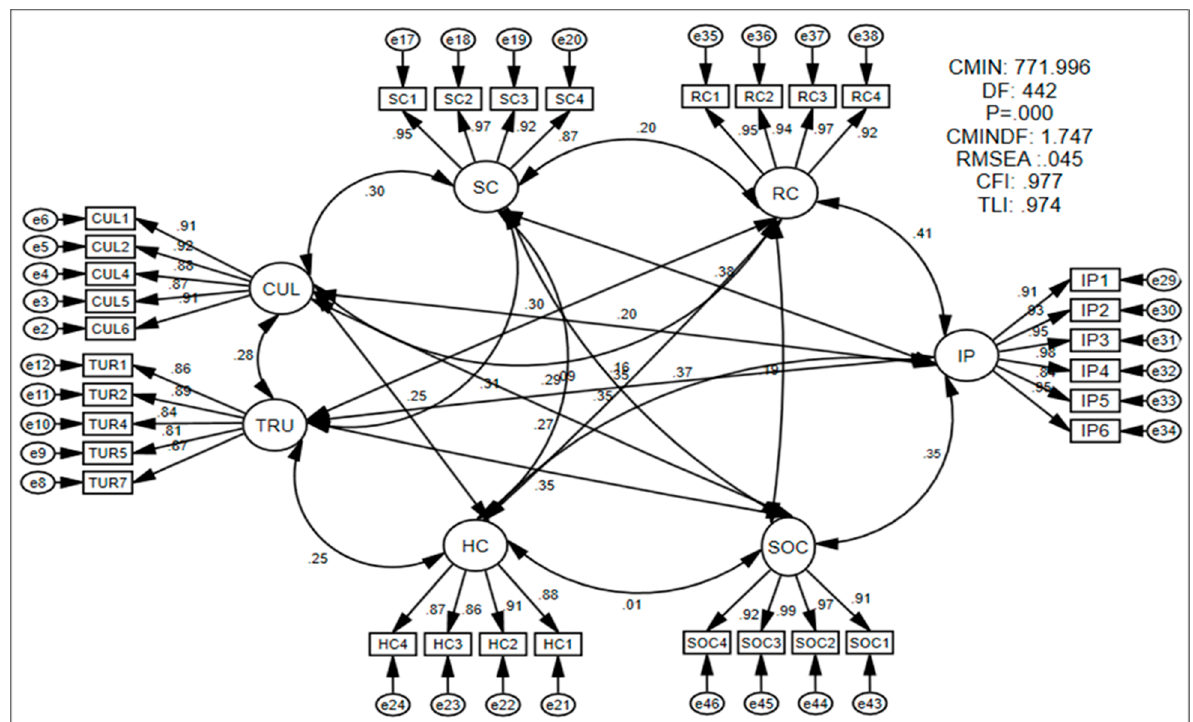
Figure 2. Assessment of measurement modelling. Note: CUL = culture; TRU = trust; HC = human capital; SC = structural capital; RC = relational capital; SOC = social capital; IP = innovation performance.